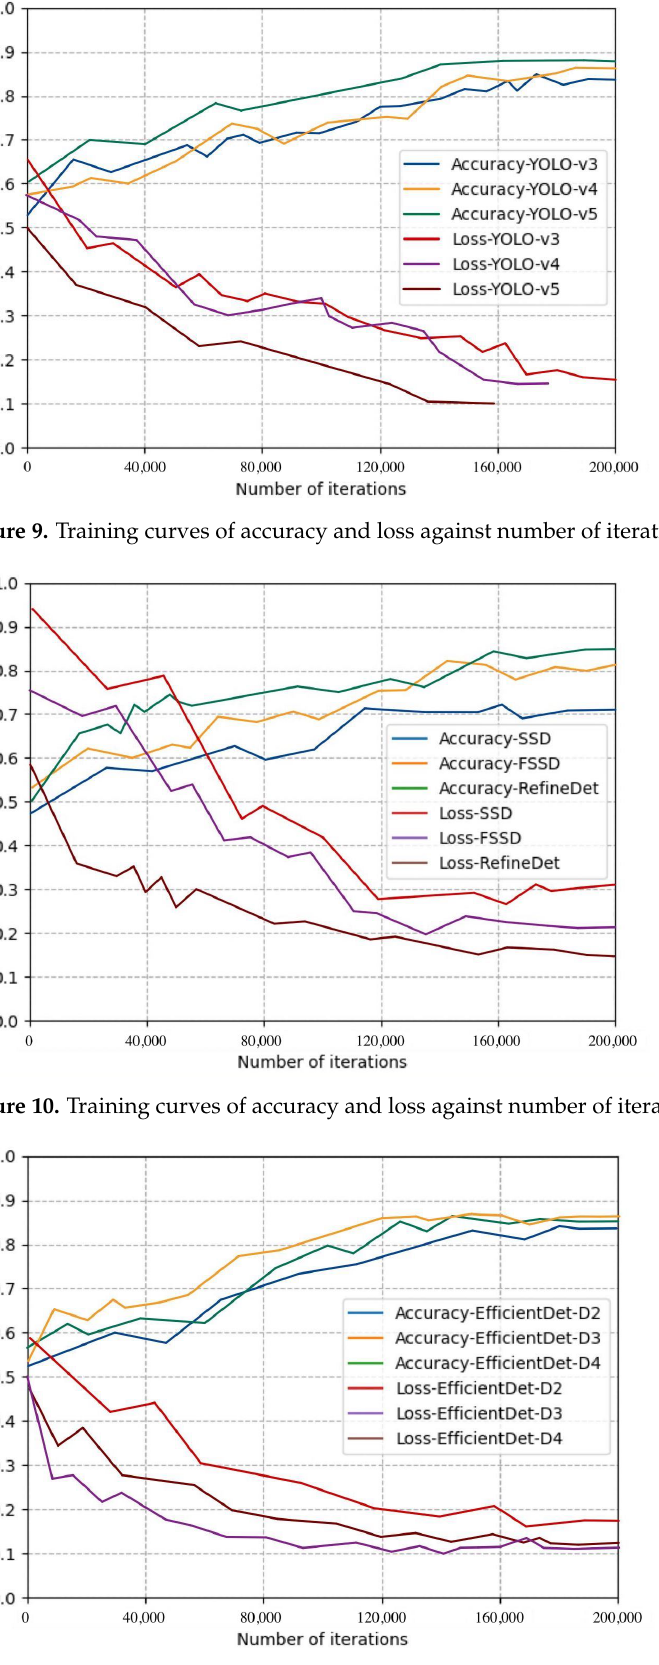
Figure 11. Training curves of accuracy and loss against number of iterations on EfficientDet series, part